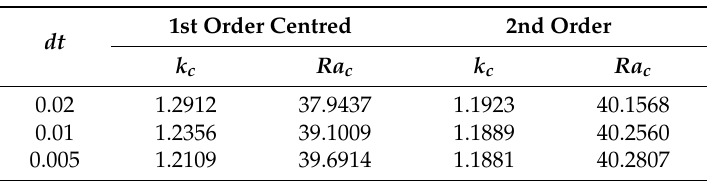
Table 2. The dependence of the critical wavenumber and Rayleigh number on the numerical method and the timestep.